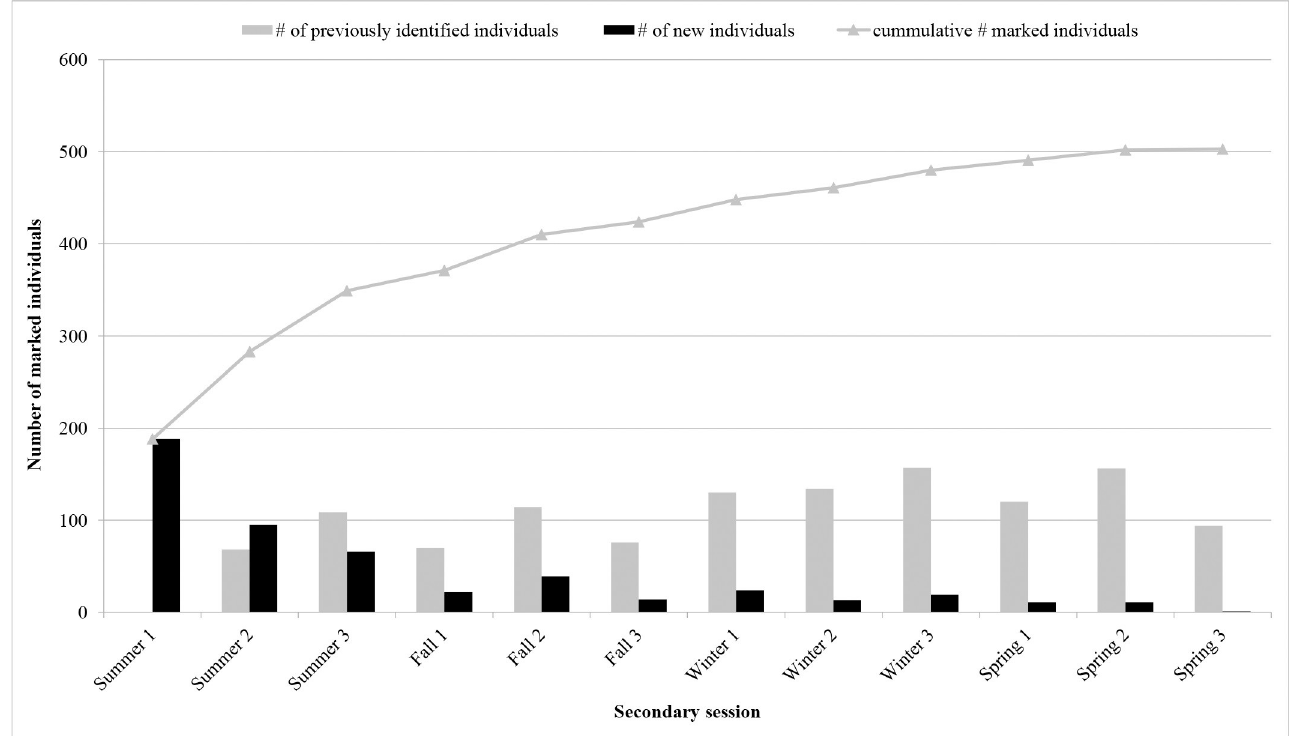
Fig 3. Number of marked bottlenose dolphins by seasonal replicate (= secondary session) during Indian River Lagoon surveys (Florida east-central coast). Superimposed onto the plot is the cumulative curve of distinct (D1) and moderately distinct (D2) individuals.